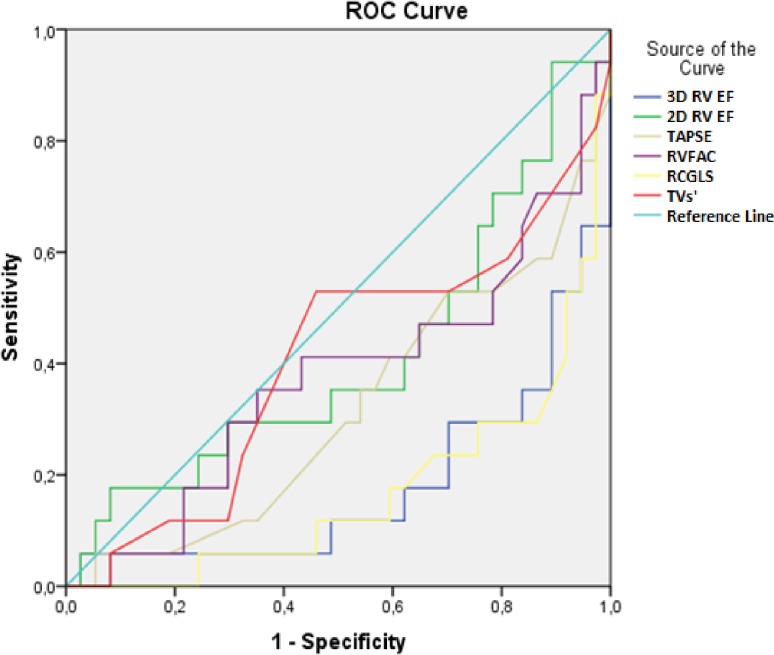
Receiving operating characteristics (ROC) curve for the selected echocardiographic parameters in relation to the VE/VCO2 slope values.